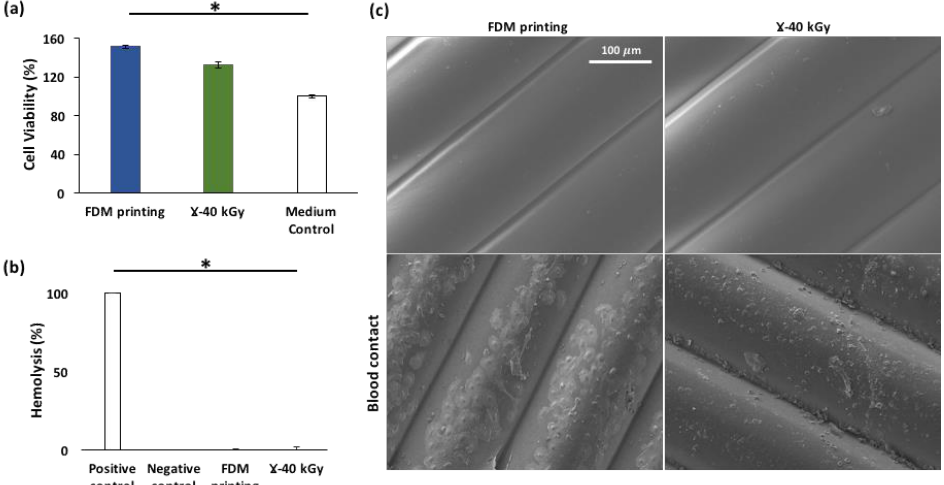
Figure 6. Impact of γ sterilization on the biological properties of FDM processed TPU constructs: cell viability ( a ); hemolysis rates ( b ); and SEM micrographs of FDM processed (without and without γ -sterilization) after blood contact ( c ) * p < 0.05 (compared to control, ANOVA